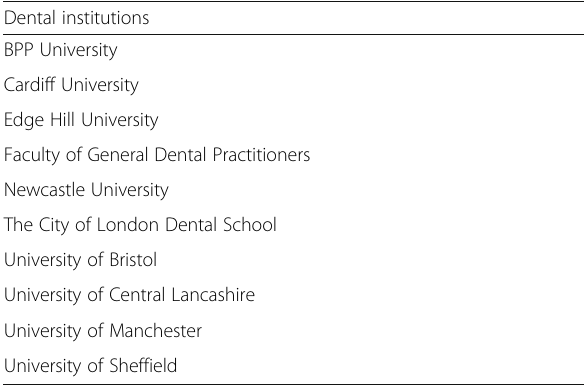
Table 2 List of dental institutions offering postgraduate